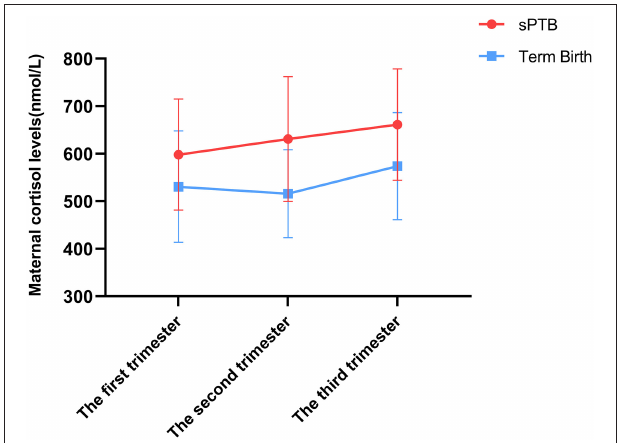
FIGURE 2 | The expression levels of cortisol in maternal serum complicated with sPTB and full-term pregnancies. The cortisol level was measured by ECLIA. Statistical significance between three comparisons was determined utilizing Student’s t -test. The sPTB group had higher cortisol level in d and third trimester, but no difference in the first